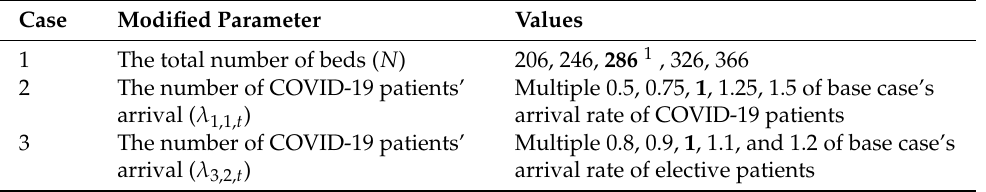
Table 2. Information on sensitivity analysis of numerical cases.